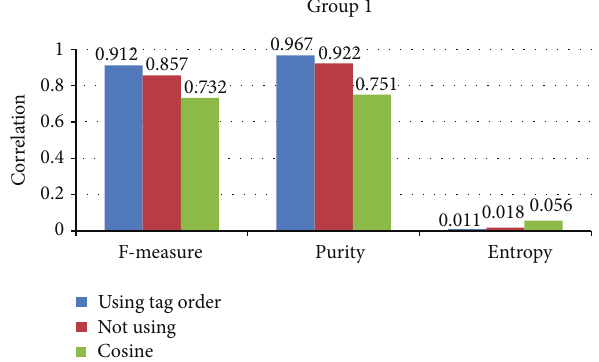
Figure 6: The clustering results of group 1 data sets.